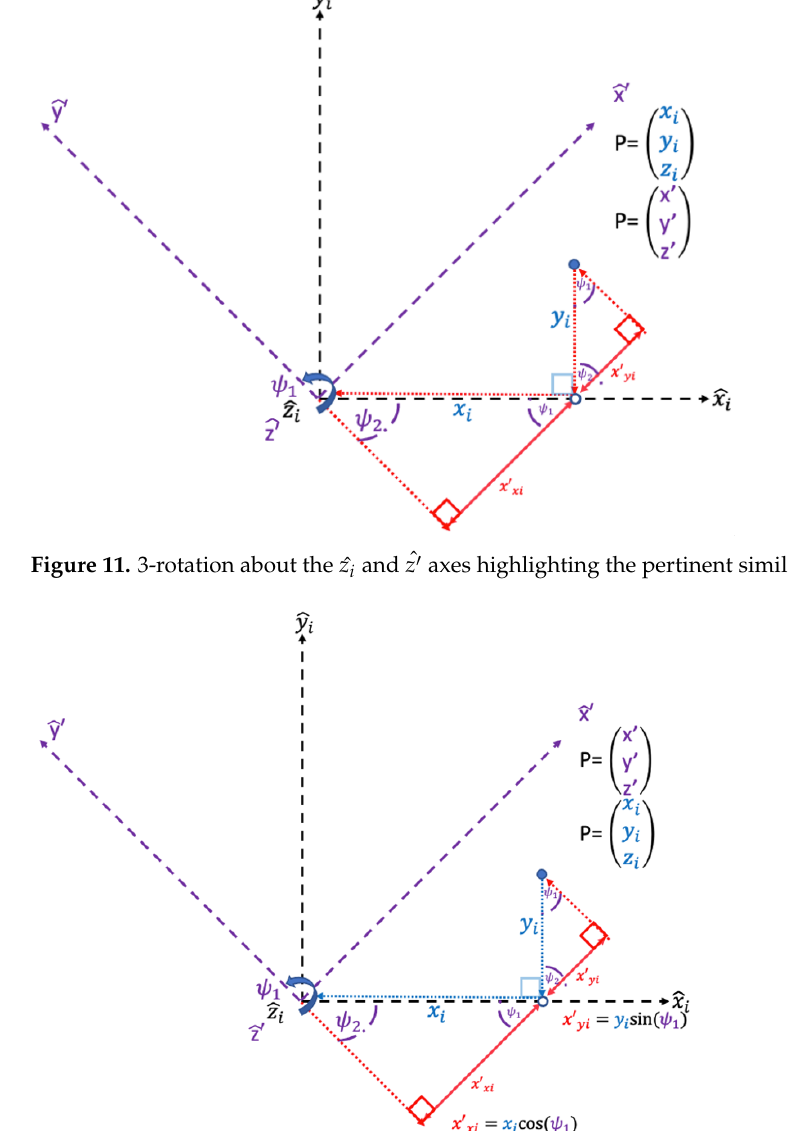
Figure 12. 3 - rotation about the 𝑧 𝑖 ̂ and 𝑧′̂ axes highlighting segments 𝑥′ 𝑥𝑖 and 𝑥′ 𝑦𝑖